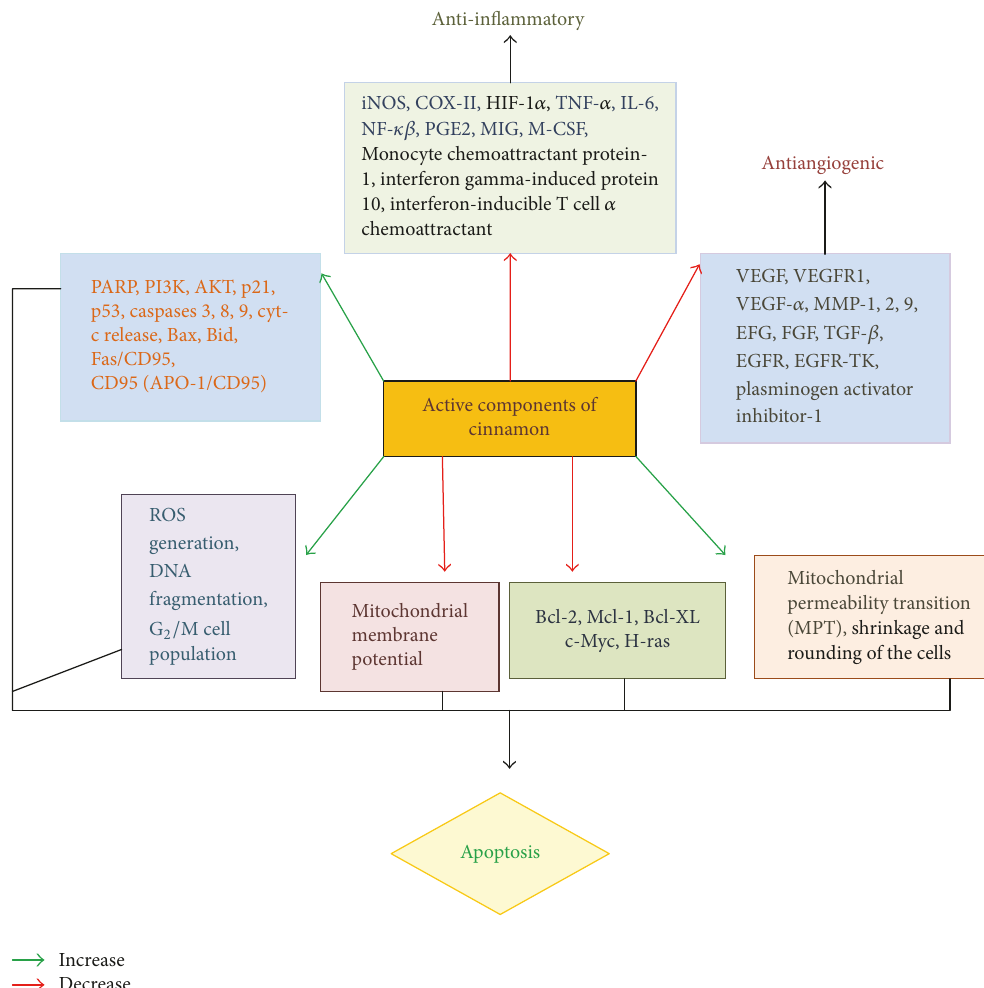
Figure 2: Action of active components of cinnamon on cancer cell growth and differentiation/apoptosis, necrosis, and